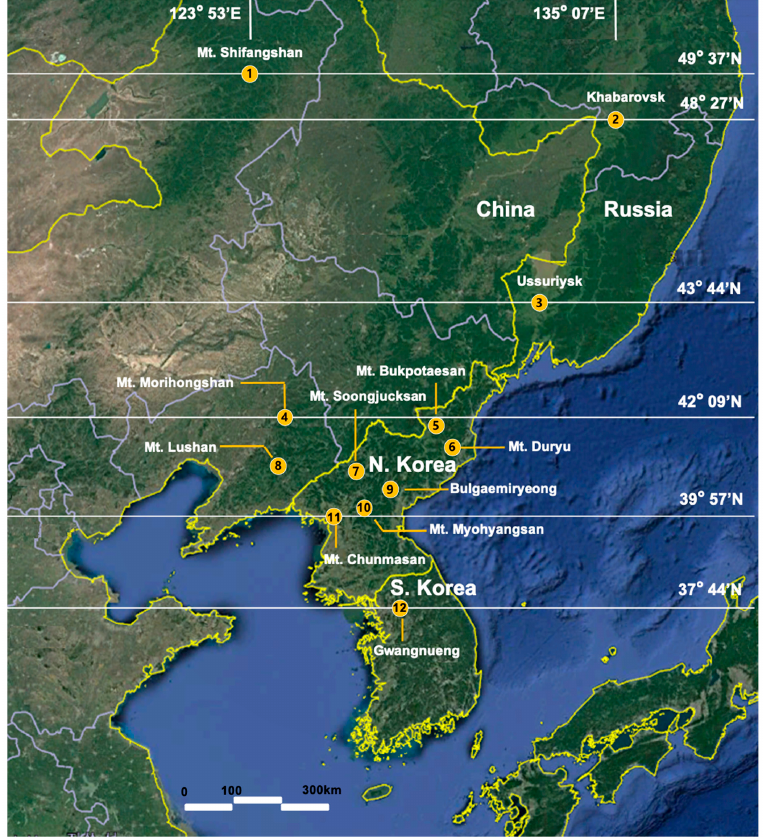
Figure 2. Sampling sites of C. relictus in the present study